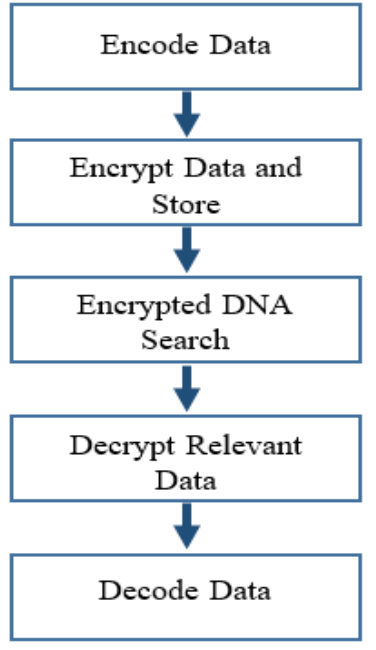
Figure 5. Process diagram to securely store the data